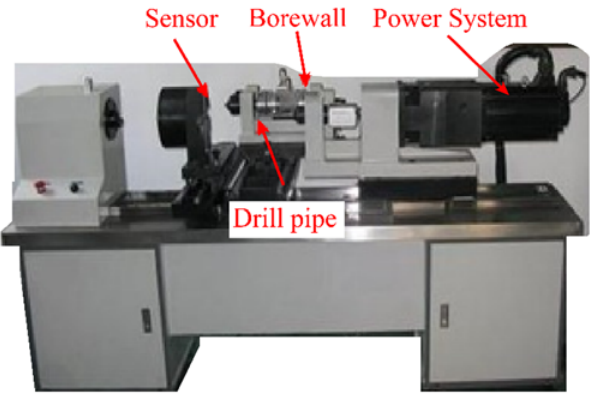
Figure 1. Experimental platform scheme.